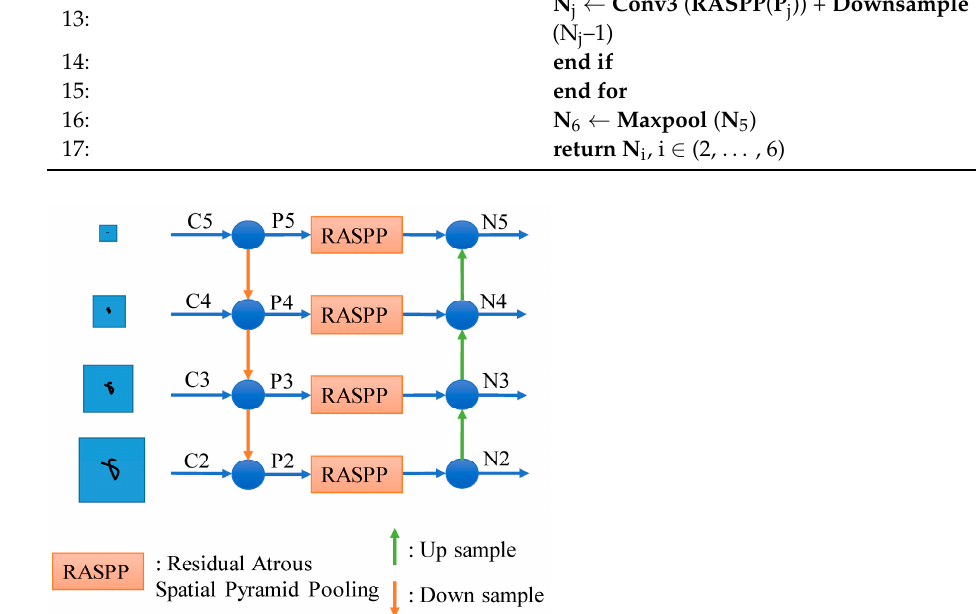
Figure 4. The structure of the proposed double pyramid network (DPN). C i /P i /N i represents features of different scales. Algorithm 1 DPN in DPN-Detector.